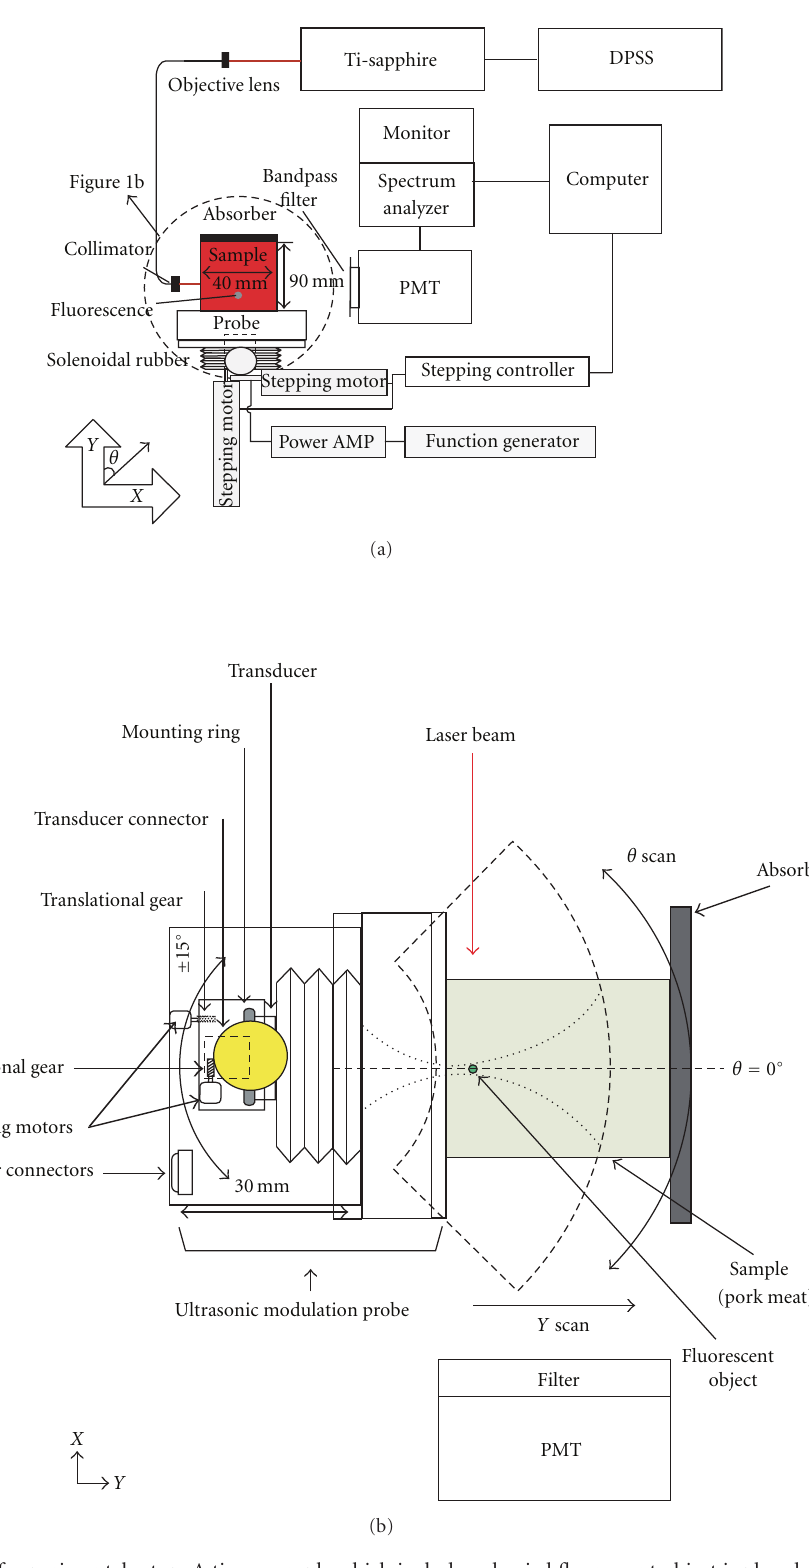
Figure 1: (a) Schematic of experimental setup. A tissue sample which includes a buried fluorescent object is placed on an adjustable plate. Probe is the combination of ultrasonic transducer with rotational and translational motion. (b) Structure diagram and operating principle of the ultrasonic modulation